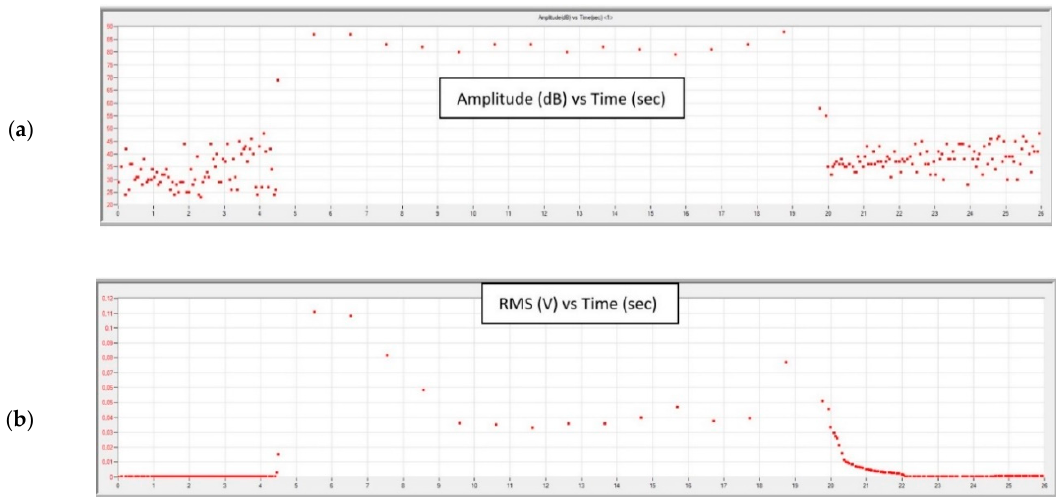
Figure 18. Charts of ( a ) amplitude and ( b ) RMS changing as a function of time during turning with parameters: ap = 2.0 mm, f = 0.1 mm / rev.